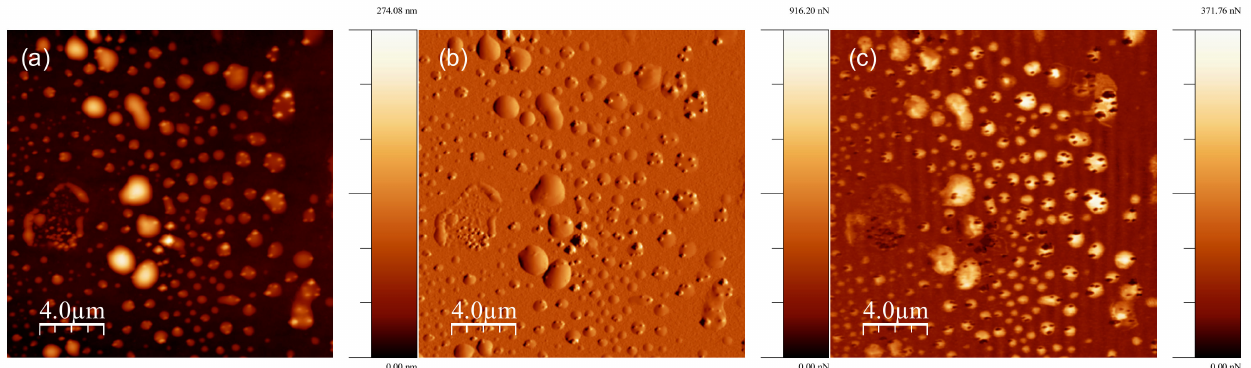
Figure 5. QNM-AFM image showing the distribution of cells with colchicine binding at a large scale on SiO 2 substrate: ( a ) AFM height image, the height of the cell is represented in color scale 0 (dark fields)–274.08 nm (light fields). ( b ) AFM force error image, the force of the cell is represented in color scale 0 (dark fields)–916.20 nN (light fields). ( c ) AFM adhesion image of the cell, the adhesion of the cell is represented in color scale 0 (dark fields)–371.76 nN (light fields).